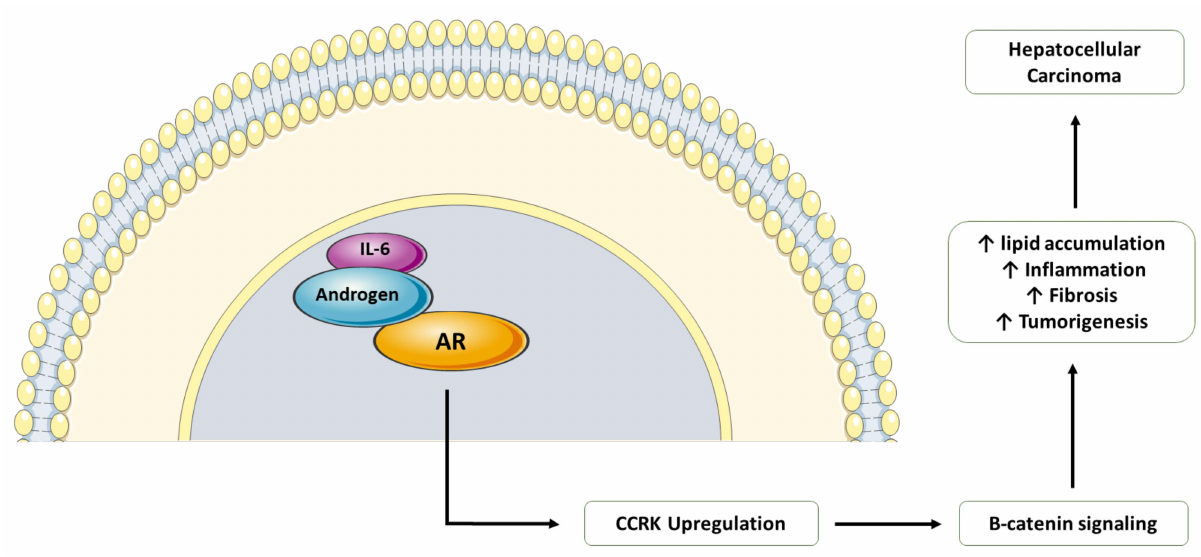
Figure 3. Role of androgens and estrogens in liver fibrosis and tumorigenesis. AR: androgen receptor, CCRK: cell cycle- related